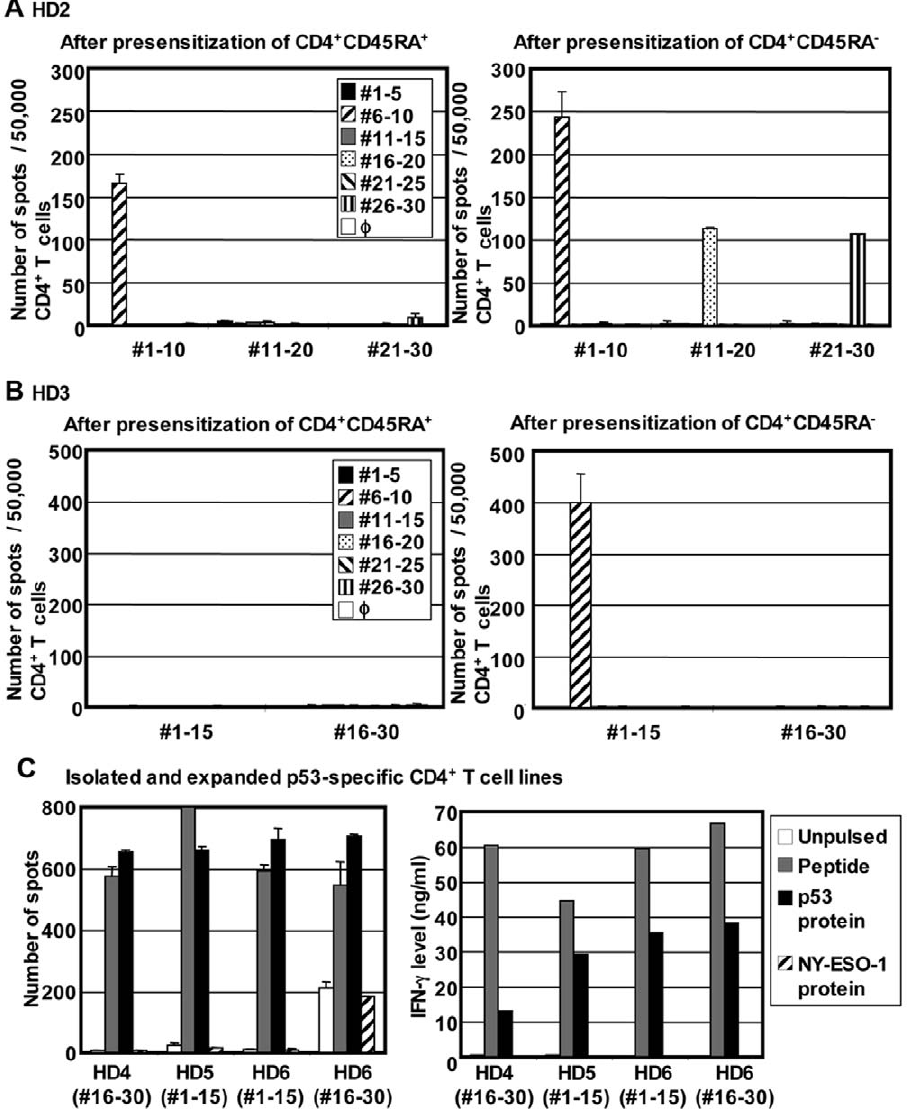
Figure 5. Characterization of p53-specific CD4 + T cells in healthy individuals. (A–B) In vivo priming of p53-specific CD4 + T cells in healthy individuals. CD4 + CD45RA + naı¨ve and CD4 + CD45RA 2 antigen-experienced T cells were isolated by flow cytometry and presensitized with p53 overlapping peptides. After 20 days, p53-specific IFN- c -producing T cells were evaluated by ELISPOT assays. Autologous T-APCs were used as APCs. (C) Recognition of naturally-processed p53 protein. p53-specific CD4 + T cell lines against p53 # 1– # 15 peptides pool or # 16– # 30 peptides pool were established from 3 healthy donors as described in materials and methods. They were stimulated by autologous mo-DC pre-pulsed with p53 peptides, p53 protein, or NY-ESO-1 protein. IFN- c production was evaluated by ELISPOT assays (left) and ELISA (right). Error bars represent SD of duplicate